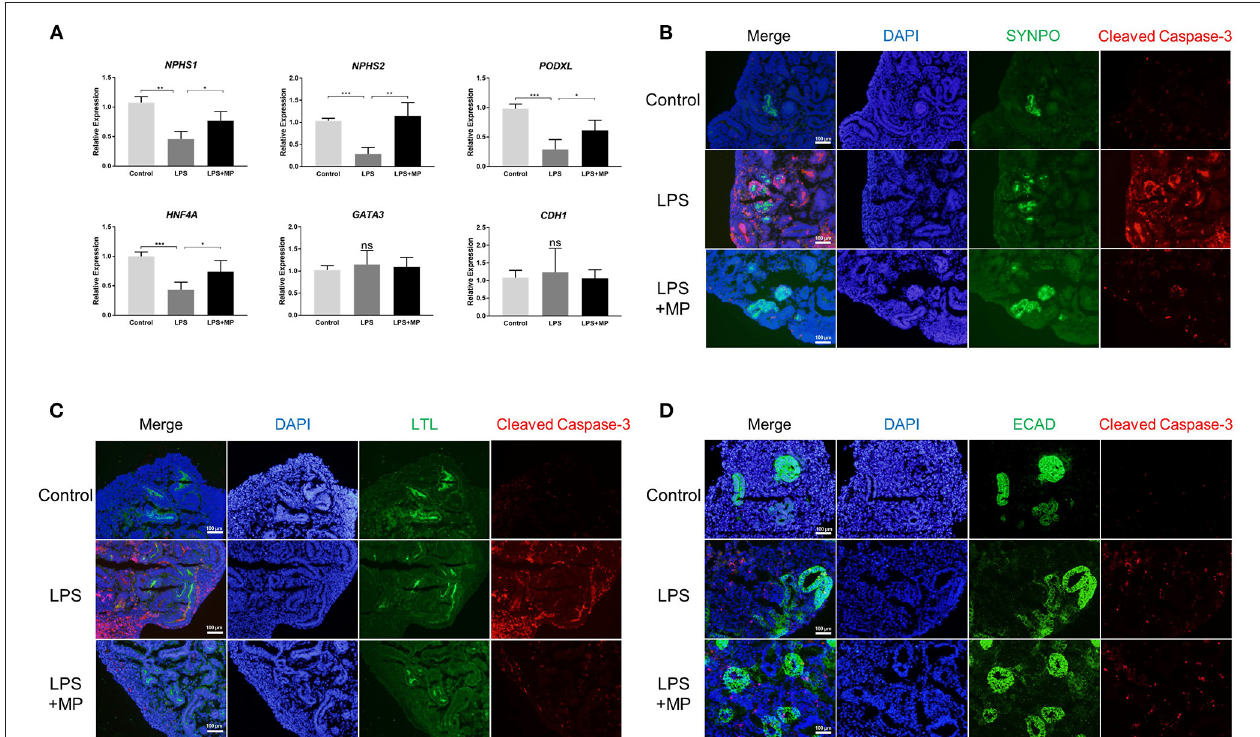
FIGURE 6 | LPS induces apoptosis mainly in podocytes and proximal tubular cells, but not in distal tubular cells. (A) Quantitative PCR analysis of the podocytes markers (NPHS1, NPHS2, PODXL), proximal tubular marker (HNF4A), and distal tubular markers (GATA3, CDH1). ns, non-significant, * P < 0.05, ** P < 0.01, *** P < 0.001. (B) Expression pattern of the podocyte marker SYNPO (Green) as well as cleaved Caspase-3 (Red) in the control, LPS, and LPS + MP treatment group. (C) Expression pattern of the proximal tubular marker LTL (Green) as well as cleaved Caspase-3 (Red). (D) Expression pattern of the distal tubular marker ECAD (Green) as well as cleaved Caspase-3 (Red). DAPI is stained with blue fluorescence. Scar bar = 100 µ